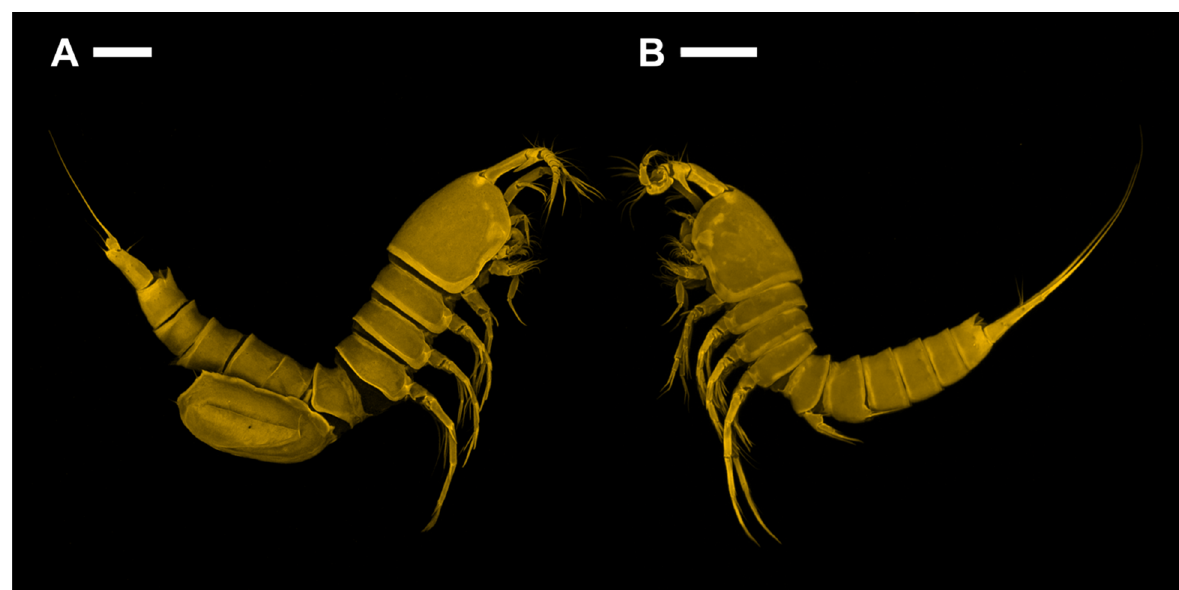
Figure 2. Confocal laser scanning microscopy images of Phyllopodopsyllus saywakimi sp. nov. ( A ) female (paratype 1): habitus, lateral; ( B ) male (paratype 10): habitus, lateral. Scale bars: 100